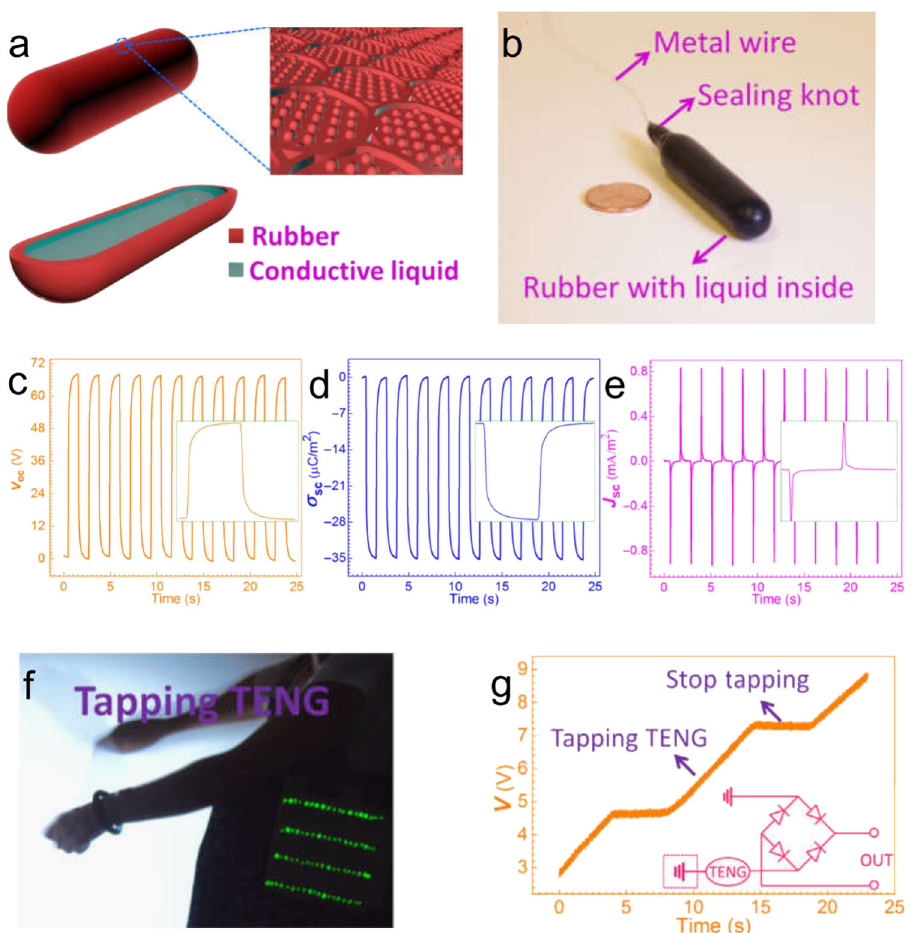
Fig. 7 a Schematic diagram of the saTENG. b A photograph of a typical unit. c – e Output signal of the saTENG when periodically touched. f A photograph showing that the saTENG lights LEDs when people tap the device. g Measured voltage of the capacitor under tapping and